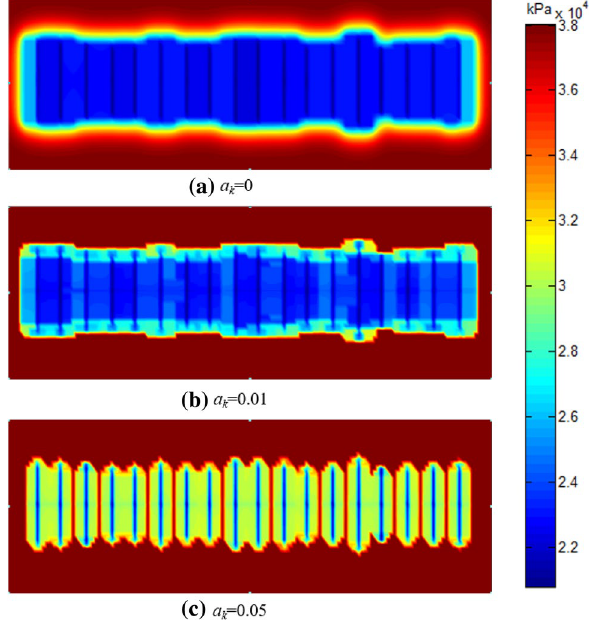
Fig. 6 Pressure maps at 4000 days